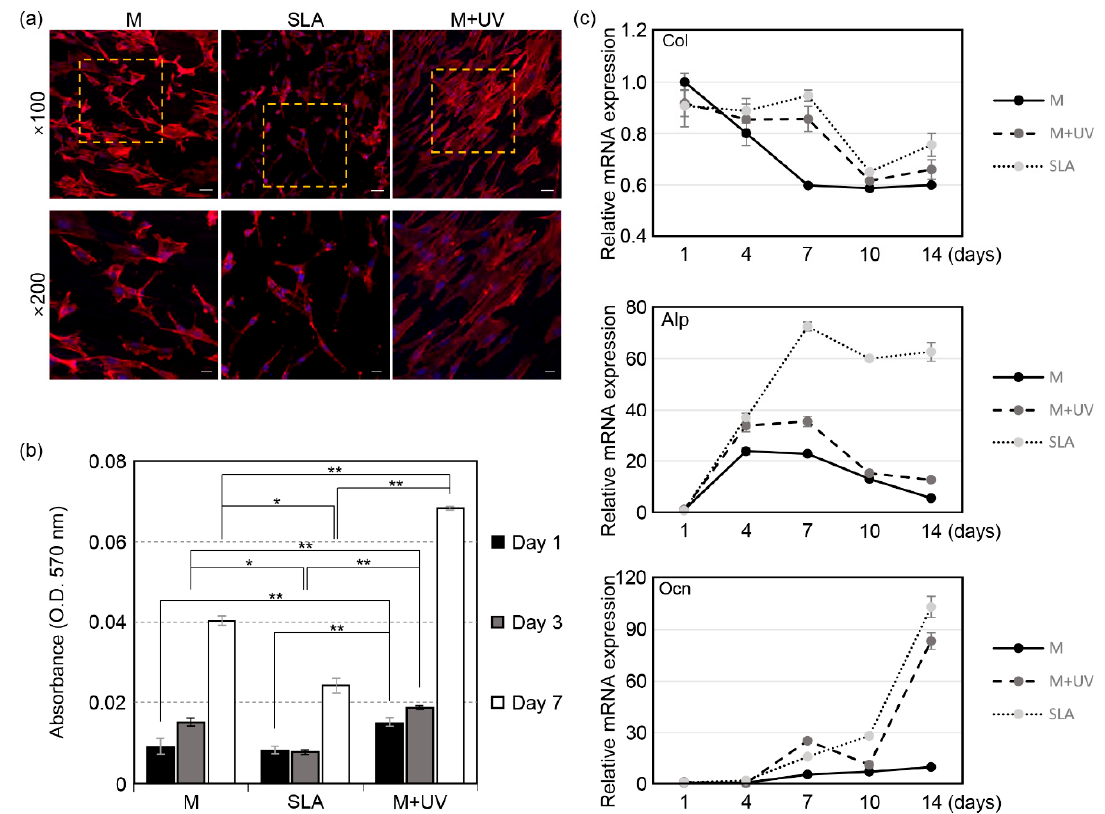
Figure 4. ( a ) Confocal microscopic images of the MC3T3-E1 cells, 24 h after being seeded on the Ti discs. The areas in the dotted box are magnified in the bottom row. Scale bars: 50 µ m at × 100 and 20 µ m at × 200 magnification. ( b ) Evaluation of cell proliferation of the MC3T3-E1 cells by an MTT assay at 1, 3, and 7 days after being seeded on the Ti discs. ( c ) Evaluation of the cell differentiation of MC3T3-E1 cells by real-time PCR at 1, 4, 7, 10, and 14 days after being seeded on the Ti discs. The relative mRNA expression levels were normalized to glyceraldehyde-3-phosphate dehydrogenase (GAPDH). The osteogenic markers are type I collagen (top), alkaline phosphatase (ALP, middle), and osteocalcin (OCN, bottom). UV photofunctionalization enhanced the osteoblastic gene expression. Error bars show the standard deviation. (*) and (**) represent the significance compared with each pair, p < 0.05 and p < 0.01, respectively.